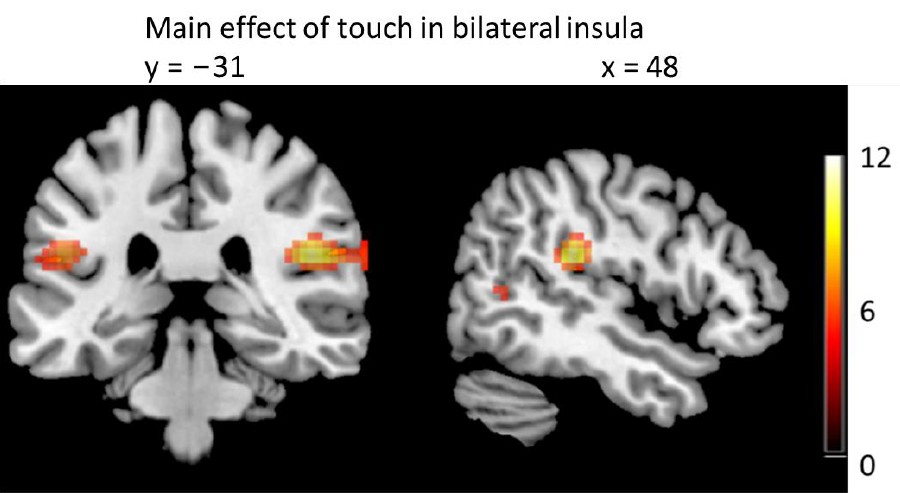
Figure 3. Stroking and tapping touch led to significant activation in bilateral posterior insula. Color bar indicates t-values. Thresholded at p < 0.05, FWE-corrected for the whole